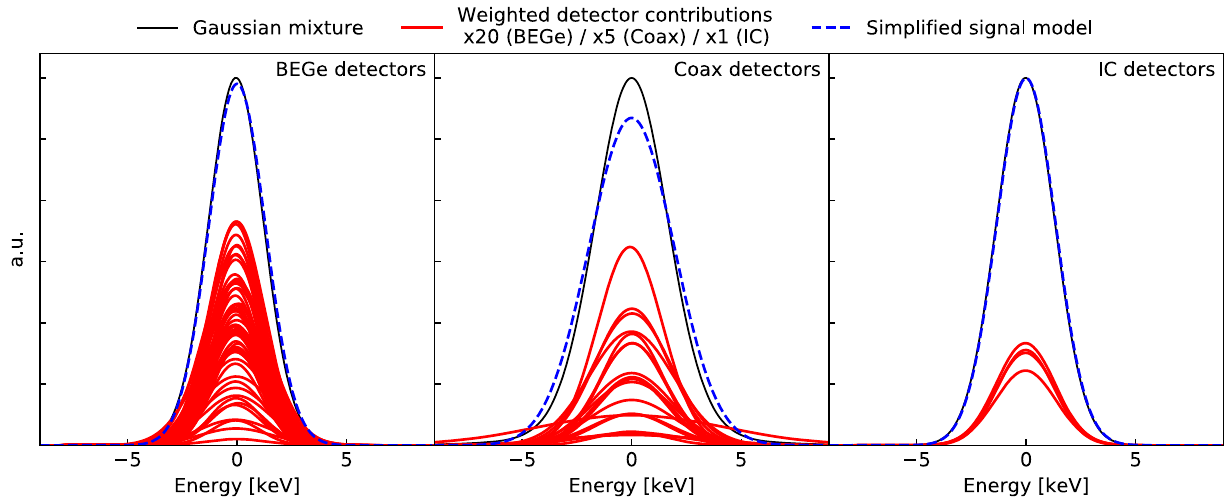
Fig. 5 Comparison of simplified Gaussian signal model (dashed blue) to the more detailed Gaussian mixture signal model (solid black) of the FEP, for DTDs formed of the partitions of BEGe (left), coaxial (mid-